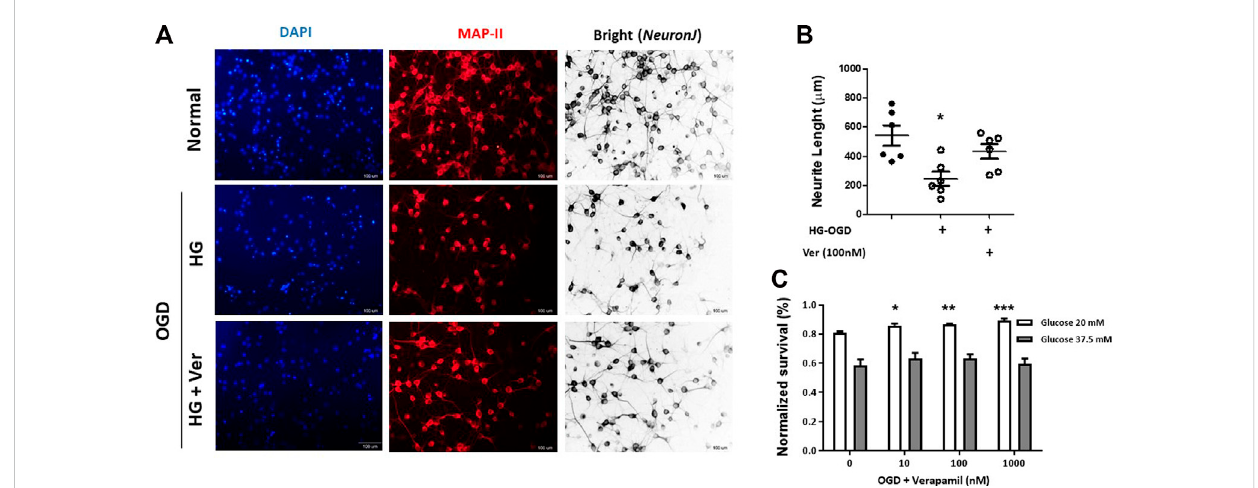
FIGURE 3 Verapamil improved cell survival and neurite growth in OGD-HGr PCN cultures. PCN cultures were exposed to OGD and incubated in normal conditions with glucose concentration of 20 mM in medium for 24 h with or without verapamil. To analyze neurite growth, PCN cells were probed for MAP-II antigen, and average neurite lengths weremeasured in1 mm 2 fi elds. Verapamil (100 nM) could partially improve neurite length in OGD-HGr PCN cells (A) .ToaddressOGD-HGrPCNcellviability,MTTassaywasperformedinculturestreatedwithverapamil(0,10,100,or1000 nM)for24 h,either